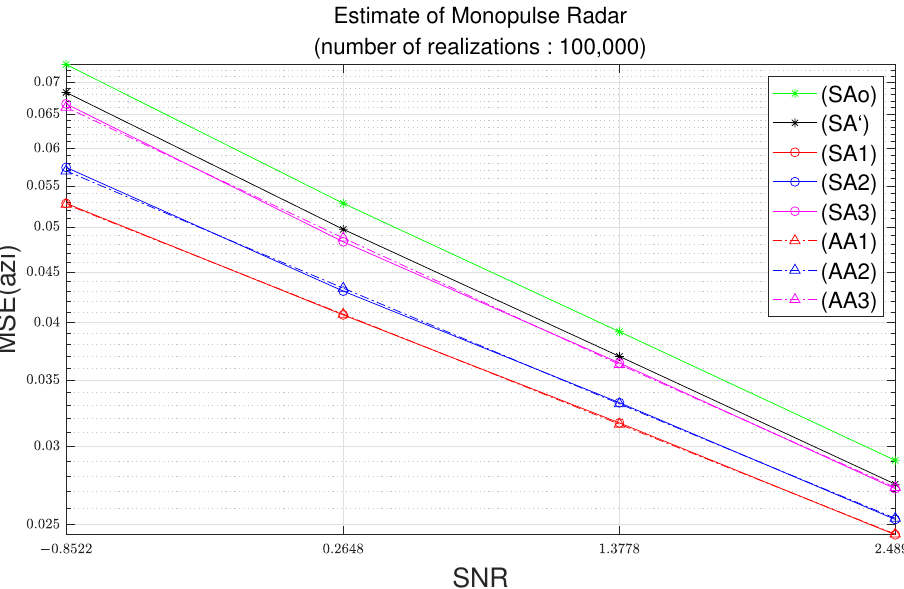
Figure 9. Azimuth MSE as function of SNR with parameters of Table 2 and 100,000